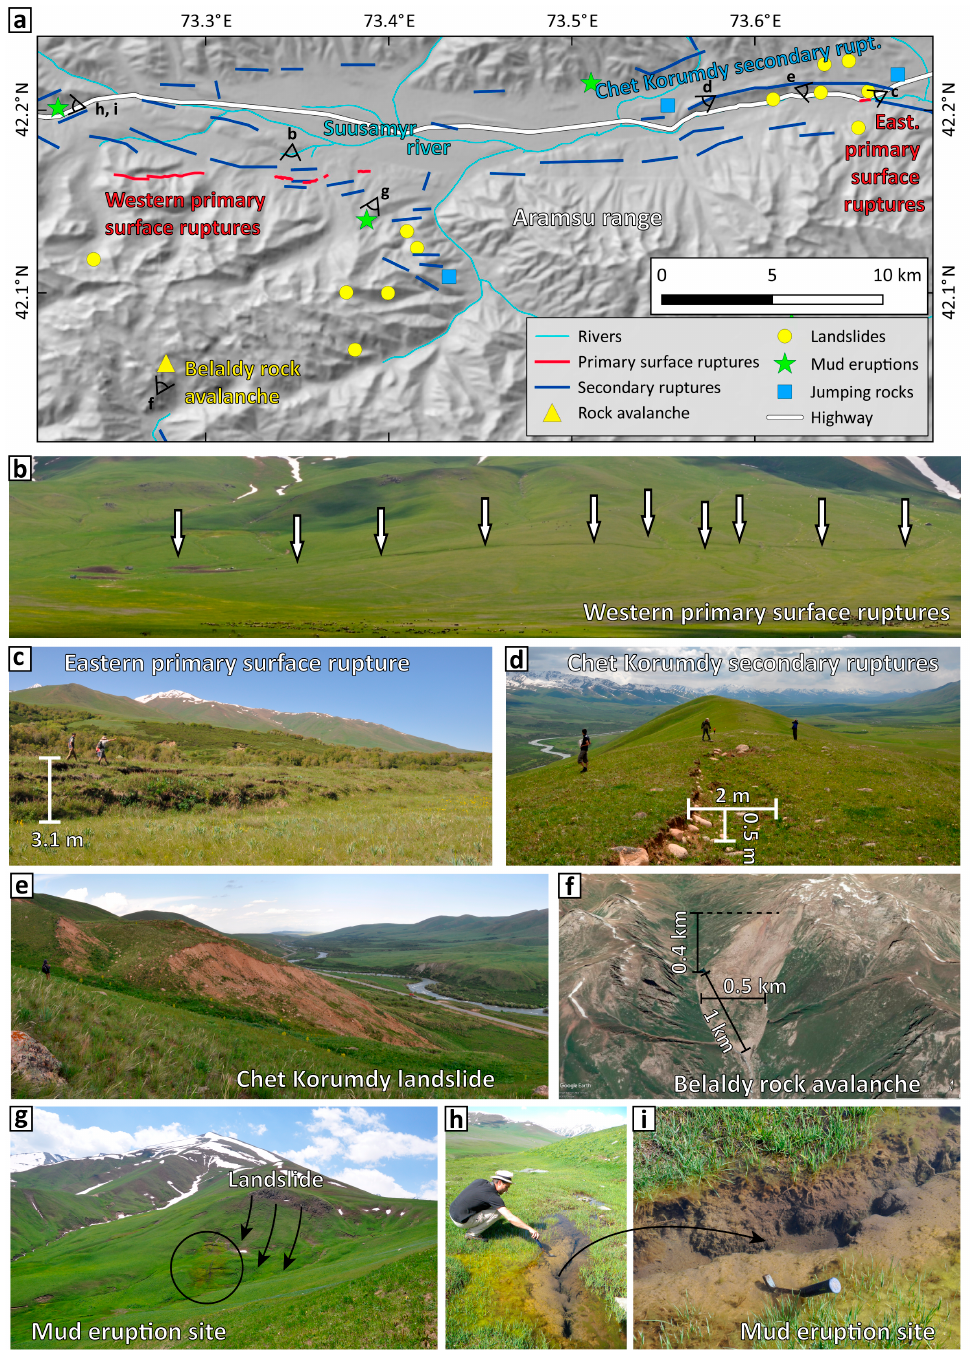
Figure 3. Earthquake environmental e ff ects of the 1992 Suusamyr Earthquake. ( a ) Map with the photo locations. ( b ) The central section of the western primary surface ruptures in summer 2015. View to the south. ( c ) The highest section of the eastern primary surface ruptures in summer 2016. View to the west. ( d ) Secondary ruptures on top of the Chet Korumdy ridge in summer 2015. View to the west. ( e ) The 1992 Chet Korumdy landslide that damaged the Bishkek-Osh highway (visible in the background) in summer 2015. View to the west. ( f ) Oblique satellite image of the Belaldy rock avalanche. Source: GoogleEarth / CNES / Airbus (2019), imagery from16 August 2013. View to the northeast. ( g ) Mud eruption site W of the Aramsu range. Note that the eruption site sits at the landslide toe. View to the southwest. ( h ) Mud eruption site in the W of the valley. This site also sits on top of a landslide. View to the west. ( i ) Close-up of the cracks from which the mud